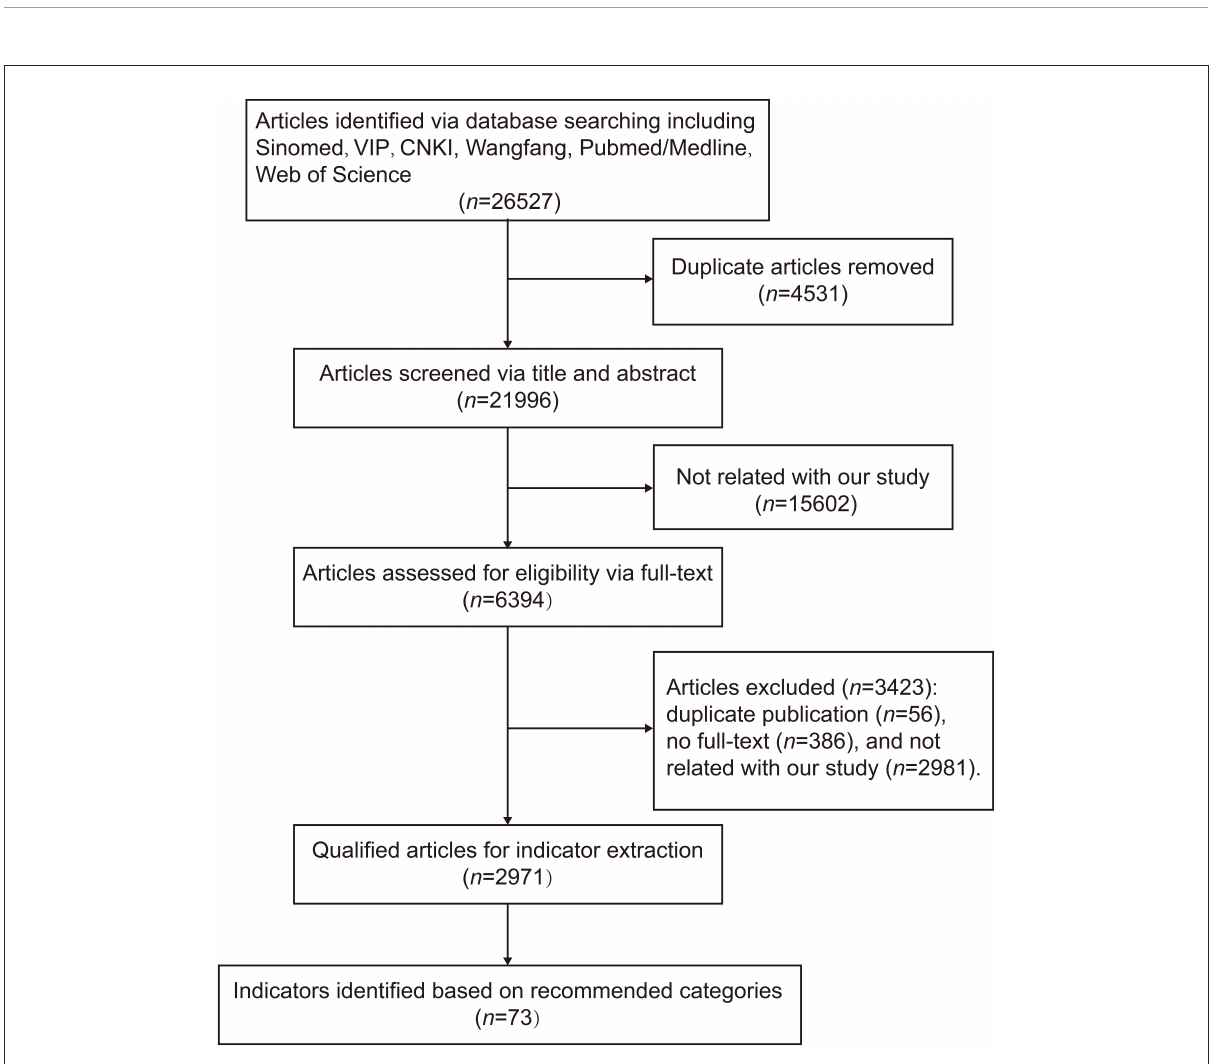
FIGURE2 Process of literature review for potential indicators. CNKI, China National Knowledge Infrastructure; Sinomed, China Biomedical Literature Database; VIP, Chongqing VIP Chinese Science and Technology Periodical